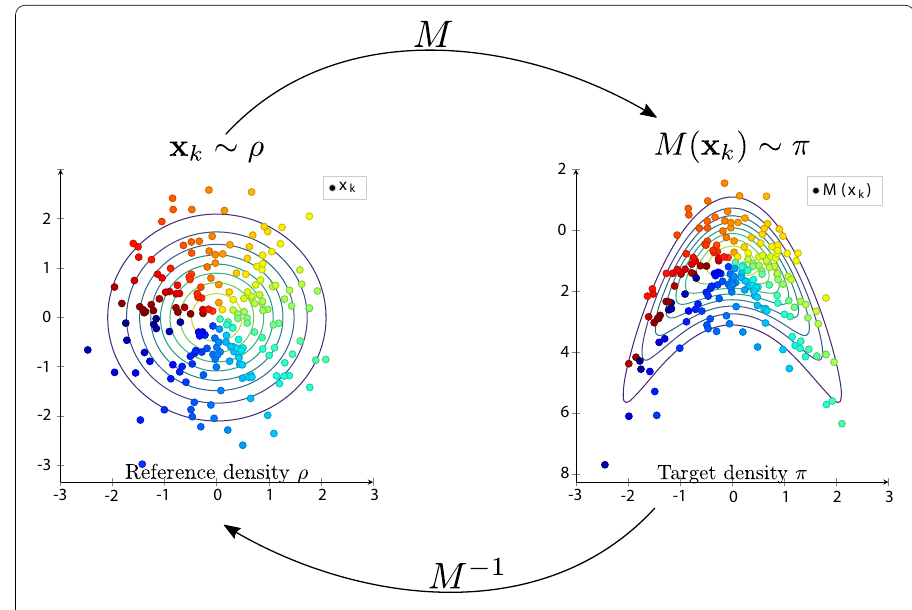
Fig. 7 Illustration of the Transport Map principle for sampling a target density